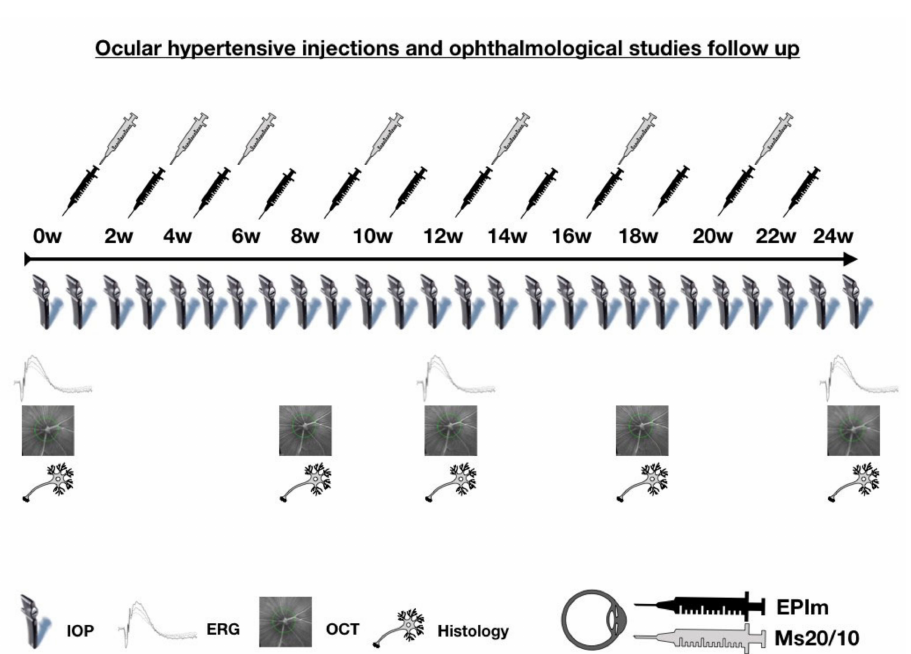
Figure 1. Ocular hypertensive injections and ophthalmological studies. Abbreviations: Ms20/10: mi- crosphere model; EPIm: episcleral sclerosis model; IOP: intraocular pressure; OCT: optical coherence tomography; ERG: electroretinography; w: